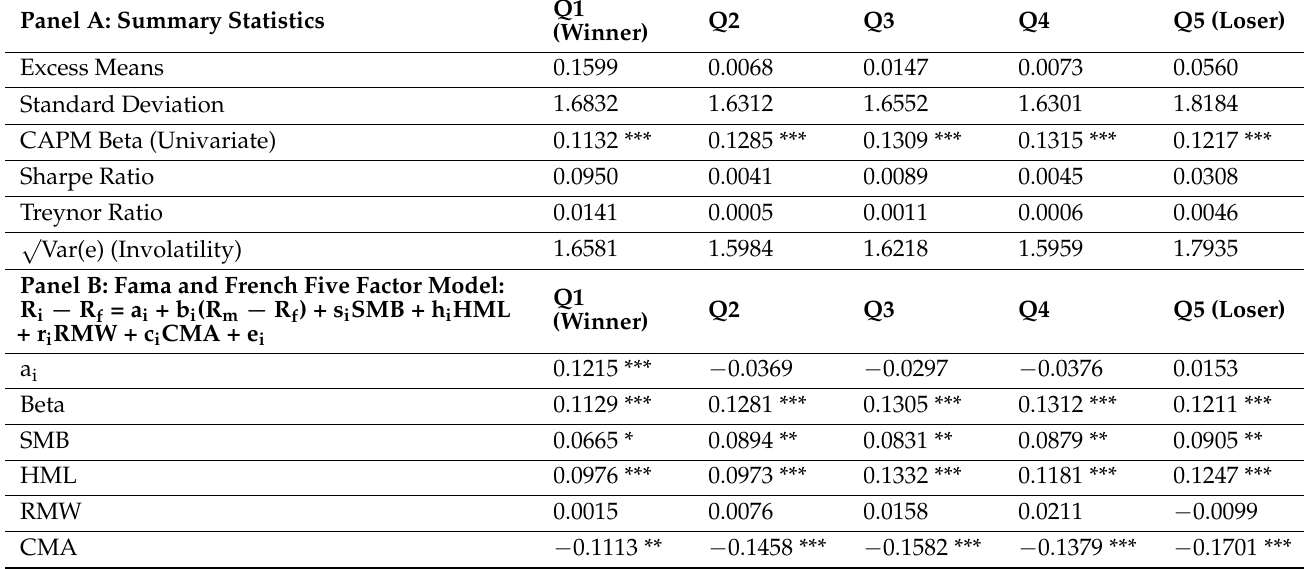
Table 6. Risk measures for Winner and Loser REIT portfolios